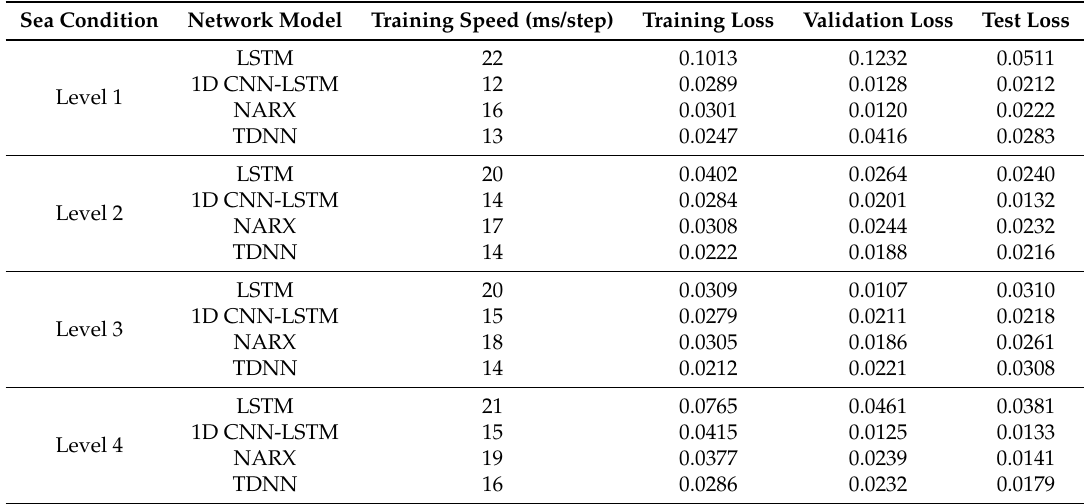
Table 3. Comparison of the results by LSTM, 1D CNN-LSTM, NARX and